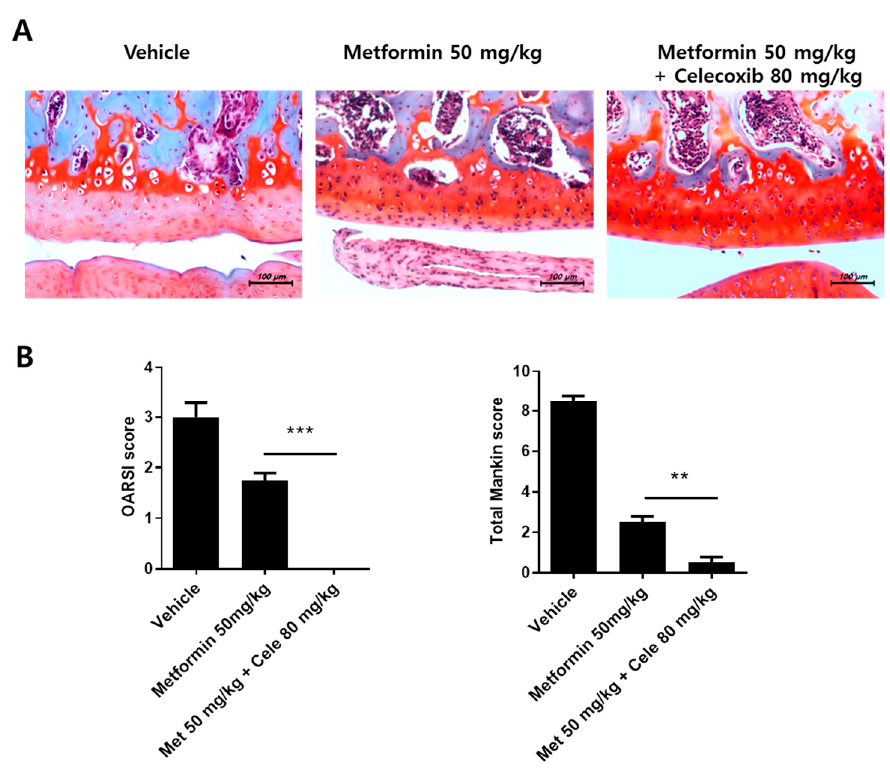
Figure 6. Combined effects of metformin and celecoxib. ( A ) OA was induced in Wistar rats by intra-articular injection of MIA. Metformin (50 mg/kg) and celecoxib (80 mg/kg) were orally administrated into OA rats for 14 days (N = 6 animals per group). Knee-joint tissue samples acquired from all OA groups at 14 days were stained with H&E and safranin O ( B ) to evaluate disease severity based on OARSI and Mankin scores. Data are represented as the mean ± SEM of three independent experiments (** p < 0.01, *** p < 0.001).